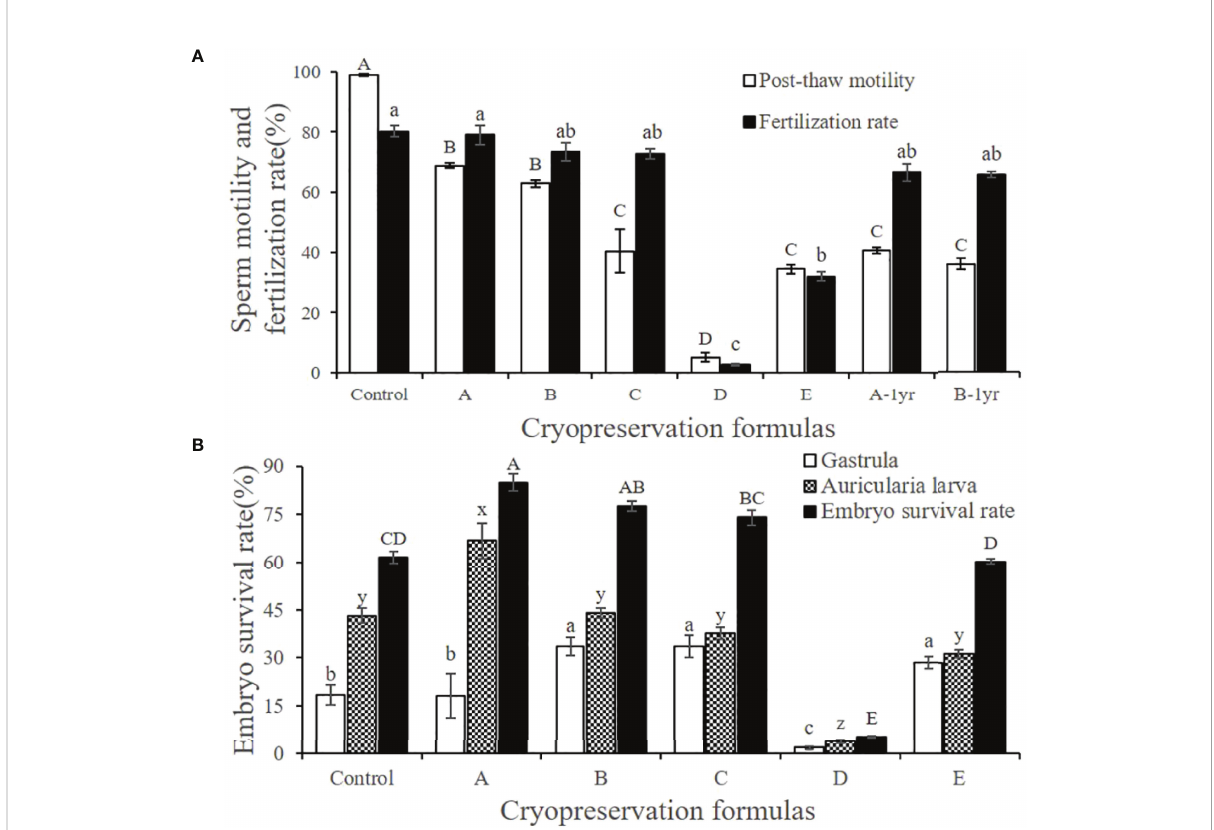
FIGURE 8 Effect of cryopreservation formulas with different post-thaw sperm motility on fertilization rate and hatching rate. (A) Post-thaw sperm motility and fertilization rate under different cryopreservation formulas. (B) Hatching rate of frozen spermatozoa under different cryopreservation formulas. Different cryopreservation formulas were (Control) Fresh unfrozen sperm; (A) 12.5% DMSO + 0.1 mol/L Glu; (B) 12.5% DMSO; (C) 20% DMA; (D) 10% EG; (E) 20% PG; (A-1yr) One-year cryopreservation of sea cucumber sperm with formula A; (B-1yr) One-year cryopreservation of sea cucumber sperm with formula (B) The rest of the freezing procedure was the same and was the optimum procedure. The fertilization rate and the hatching rate were calculated at 10 h (blastocyst stage) and 52 h (early auricularia larva stage) after fertilization. Data are presented as the means ± SE (n = 6). Different letters indicate signi fi cant differences (P < 0.05). Data were not transformed when performing one-way